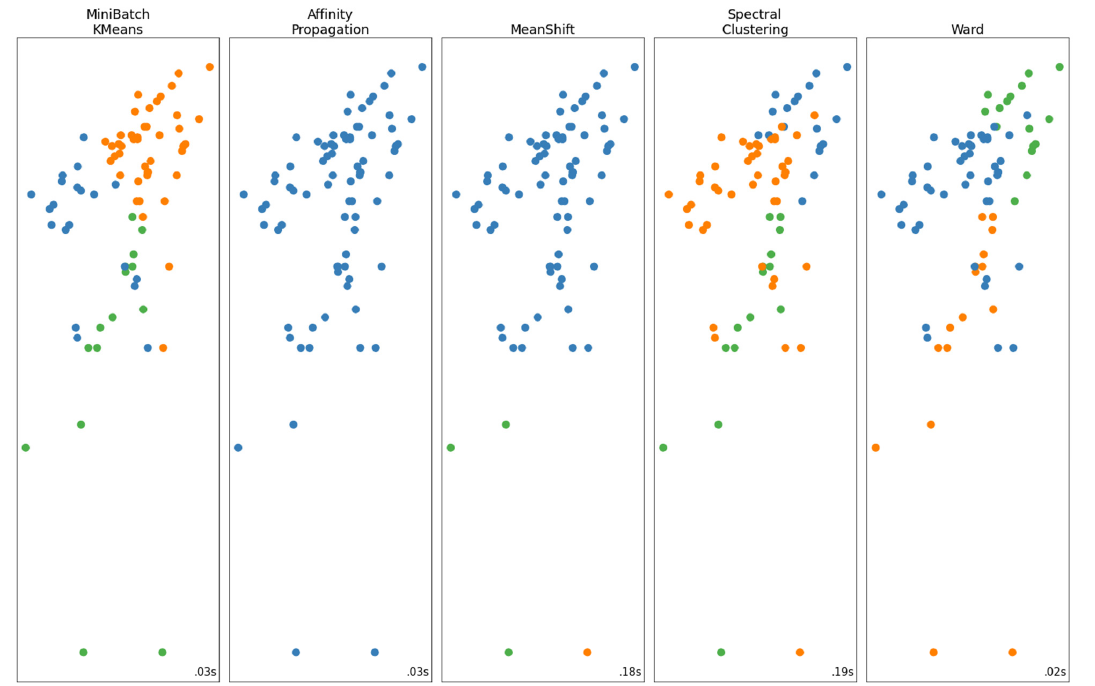
Figure A1. Attempt to partition the stage–discharge measurements of Sakoulevas River with the clustering methods: MiniBatch Kmeans, Affinity Propagation, MeanShif, Spectral Clustering, and Ward. Different colours indicate different classes. Black dots correspond to outliers. The x ‐ axis is the discharge, the y ‐ axis is the stage.